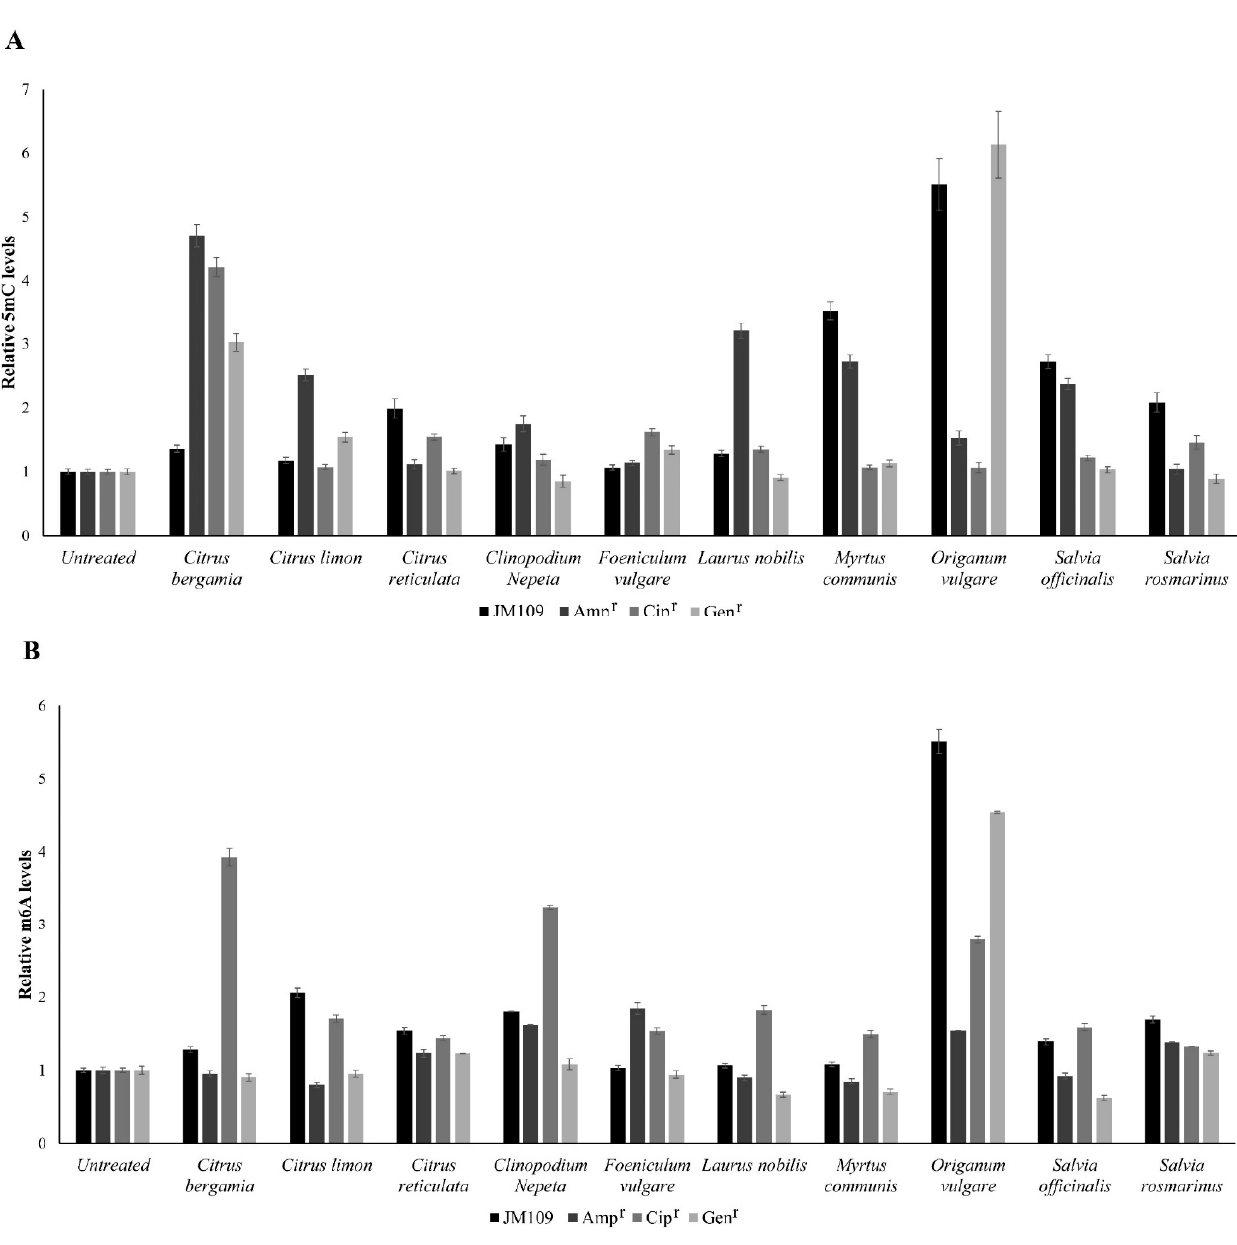
Figure 1. Methylation levels of 5-methylcytosine (5mC) ( A ) and N6-methyladenosine (m6A) ( B ) residues in DNA samples extracted from the Escherichia coli JM109 strain, and ampicillin-, ciprofloxacin-, and gentamicin-resistant cell lines at basal conditions (untreated) and after treatment with pre-MIC concentrations of the essential oils. The values represent the mean of three independent triplicate experiments with standard error.